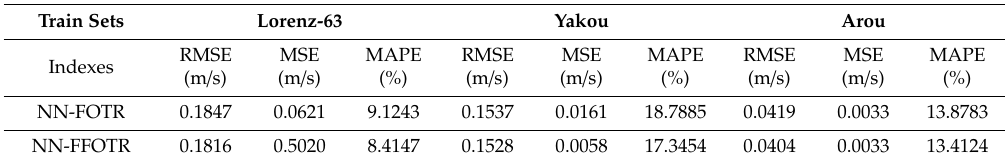
Table 2. Performance indexes evaluation of the neural network prediction model under di ff erent training rule.